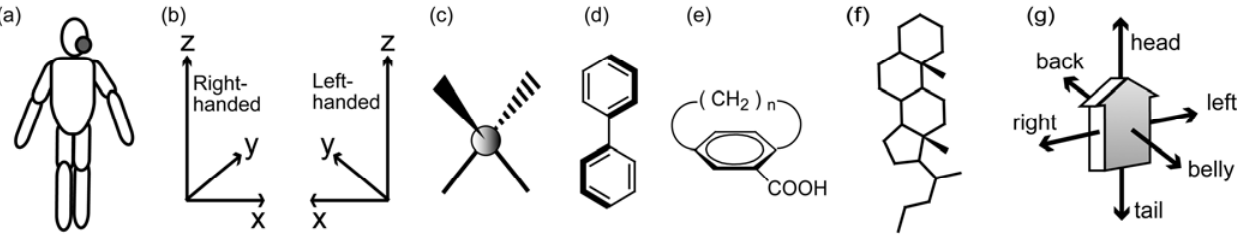
Figure 9. Three-axial chirality of materials. Human (a), mathematical three axes with right-handed or left-handedness (b), molecules with center (c), axial (d), and plane (e) chirality, a steroidal molecule (f), and a facial material with three-axial chirality